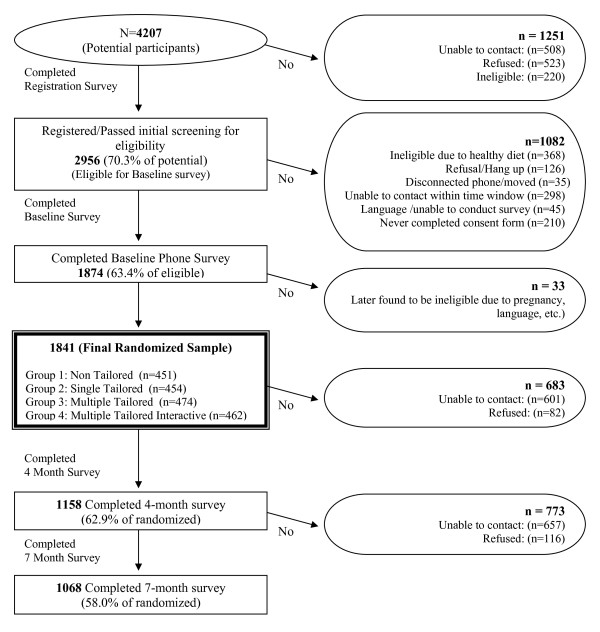
YHL-SVS sample size flow chart.